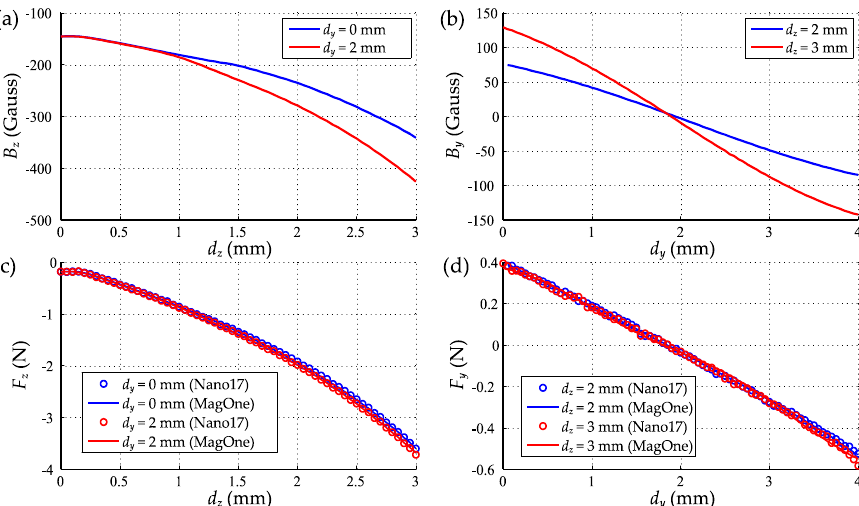
Figure 12. ( a ) B z during the z axis indentation (applying normal force) with different shear forces applied; ( b ) Normal force output during the z axis indentation with different shear forces applied (the circle represents the reference force from Nano17; the line represents the calibrated output from MagOne); ( c ) B y during the y axis indentation (applying shear force) with different normal forces applied; ( d ) Shear force output during the y axis indentation with different normal forces applied (same configuration as ( b )).